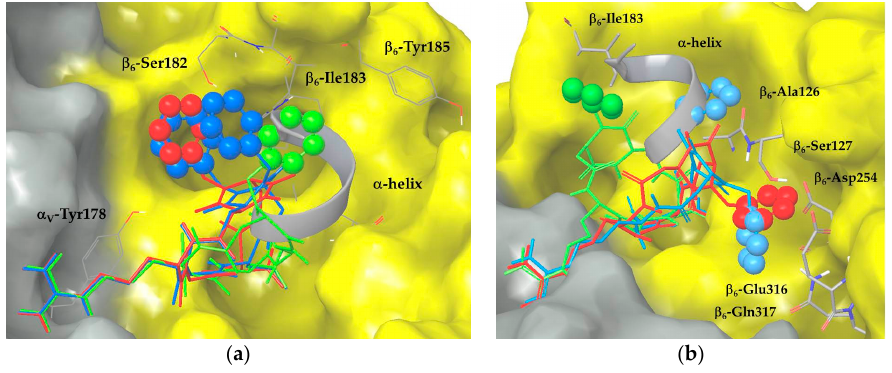
Figure 3. Docking best poses of ( a ) ligands 2 (red), 4 (green) and 5 (blue) and ( b ) ligands 3 (red), 6 (green) and 7 (blue) into integrin α V β 6 ( α V surface in grey, β 6 surface in yellow). The X-ray structure of the TGF- β 3 α -helix portion is shown as a grey ribbon. Ligand aromatic rings are represented as space-filling spheres.